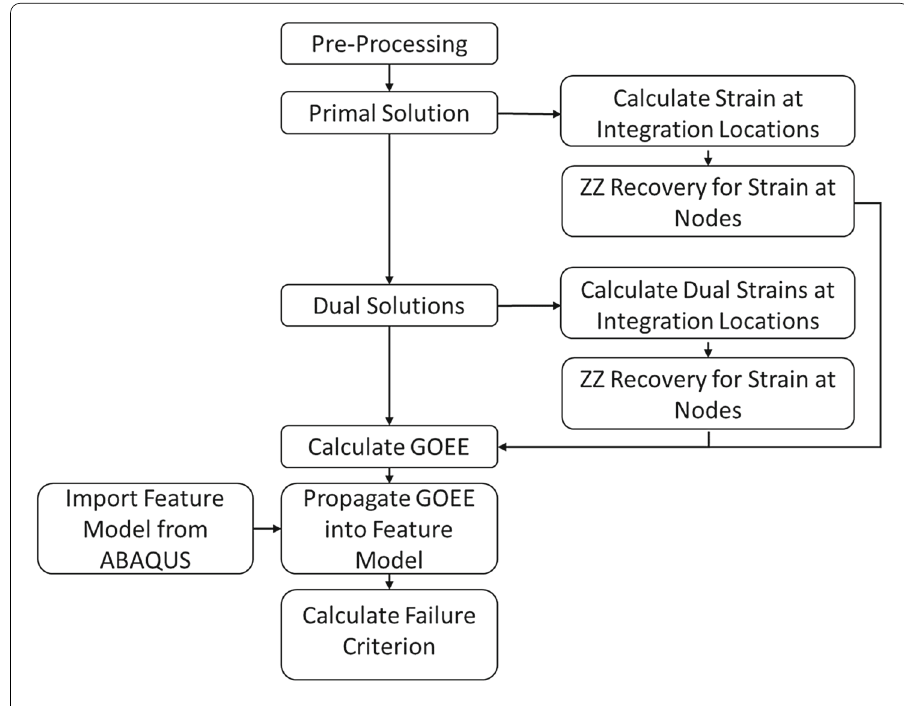
Fig. 1. In “Global GOEE approach” Section, the definition of the dual formulation,